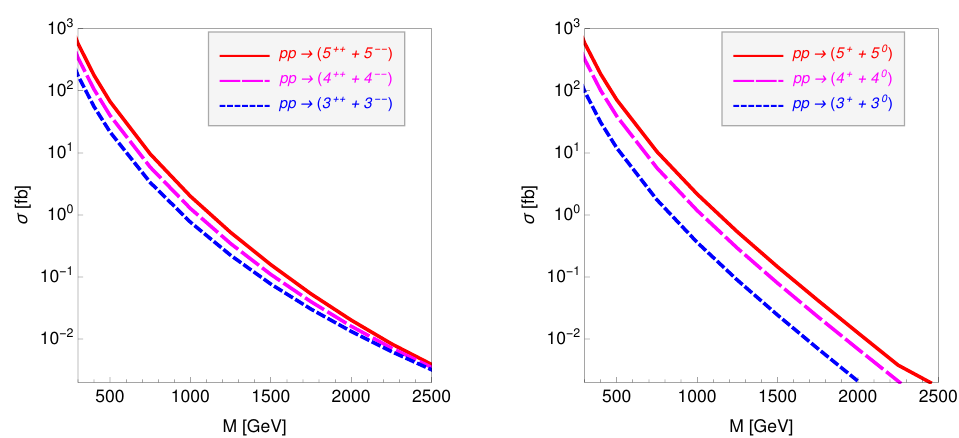
p s = , 4 F or 5 F . 1 0 1 = 2